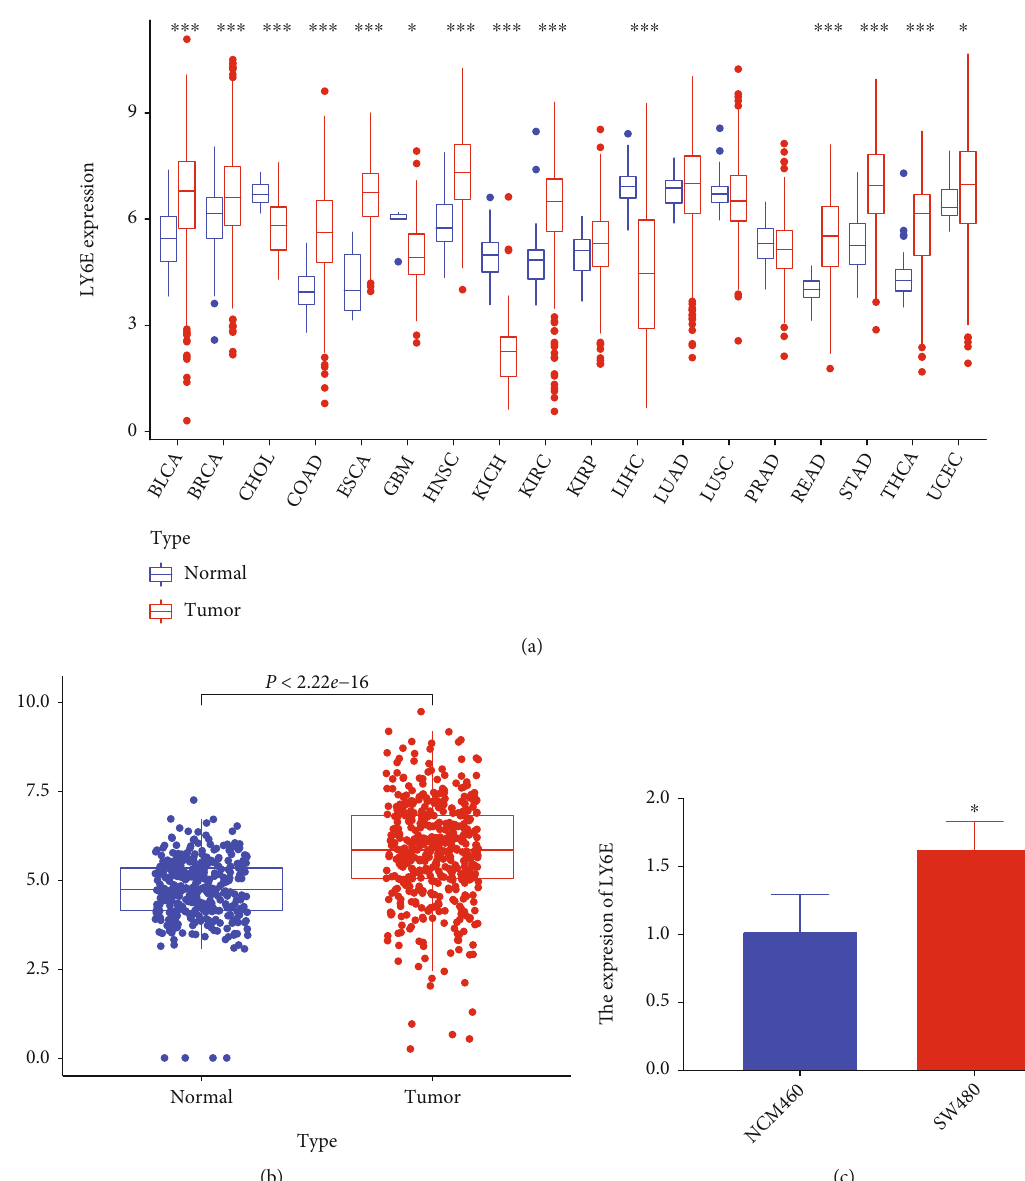
Figure 1: LY6E expression levels in pan-carcinoma and colorectal cancer (CRC). (a) TCGA cohort analysis of the mRNA expression of LY6E between normal and tumor tissues. (b) TCGA combined GTEx database shows that LY6E is upregulated in CRC. (c) The expression of LY6E in human normal colon epithelial cell NCM460 and human colorectal cancer cell line